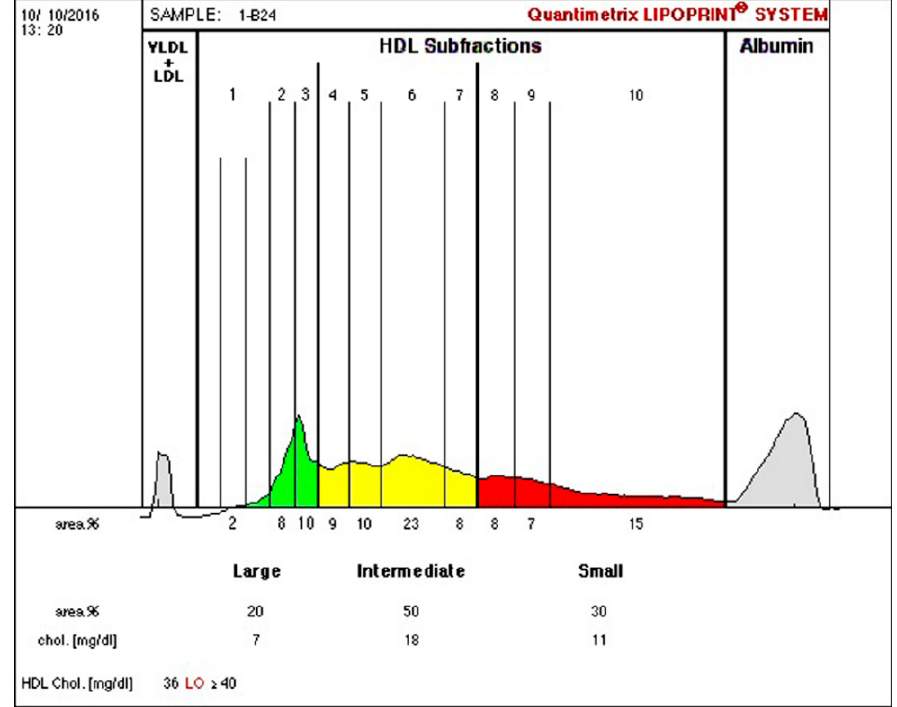
Figure 1. High ‐ density lipoprotein cholesterol (HDL ‐ C) separation before therapy, indicating 20% of Figure 1. High-density lipoprotein cholesterol (HDL-C) separation before therapy, indicating 20% of large (green), 50% of intermediate (yellow), and 30% of small (red) HDL sub ‐ fractions. large (green), 50% of intermediate (yellow), and 30% of small (red) HDL